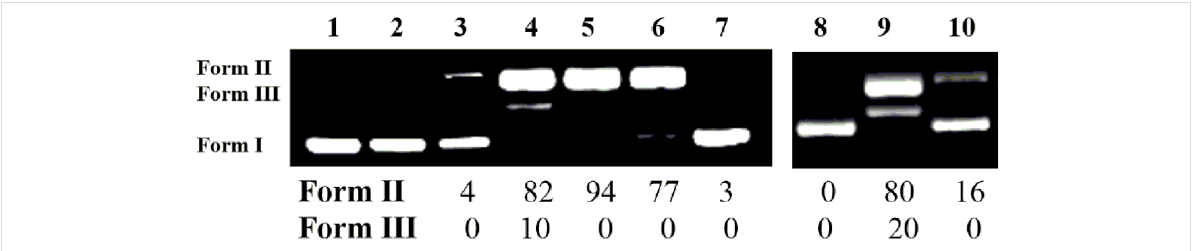
Figure 9: DNA photocleavage of compound 12 at a concentration of 500 μ M, at 312 nm, in the absence and presence of FL and CR, as quenchers. wells 1 and 2 represent DNA in dark and DNA UV irradiated, respectively. Photo: well 3: DNA + FL (100 μ M) + UV; wells 4–7: DNA + 12 + UV + FL (10, or 25, or 50, or 100 μ M, respectively; well 8: DNA + CR (200 μ M) + UV; lane 9: DNA + 12 + UV; lane 10: DNA + 12 + CR (200 μ M) +